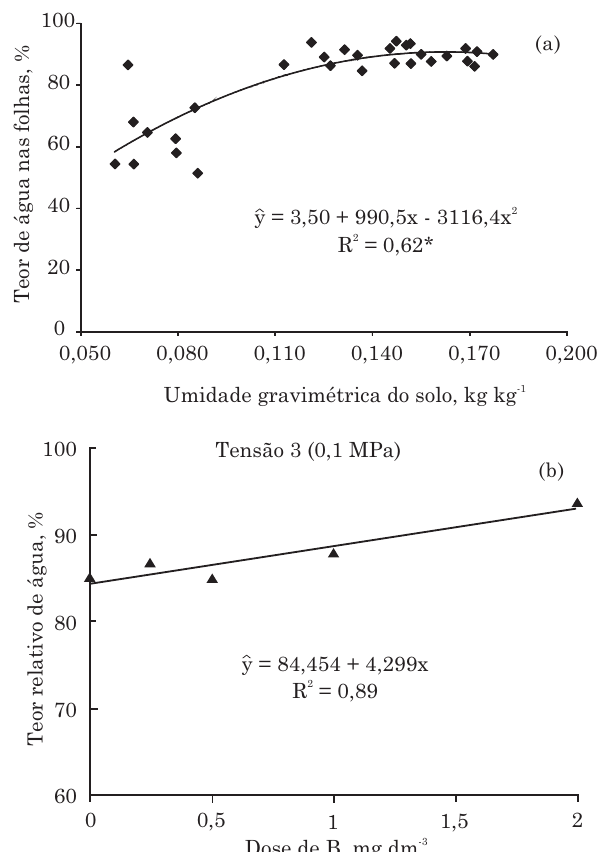
Figura 2. Ajuste obtido entre os valores de teor relativo de água nas folhas e a umidade gravimétrica do Latossolo Vermelho eutroférrico de textura arenosa, no último dia de avaliação (a); e teor relativo de água nas folhas de soja no primeiro dia avaliação em função da tensão de água no solo e das doses de B aplicadas